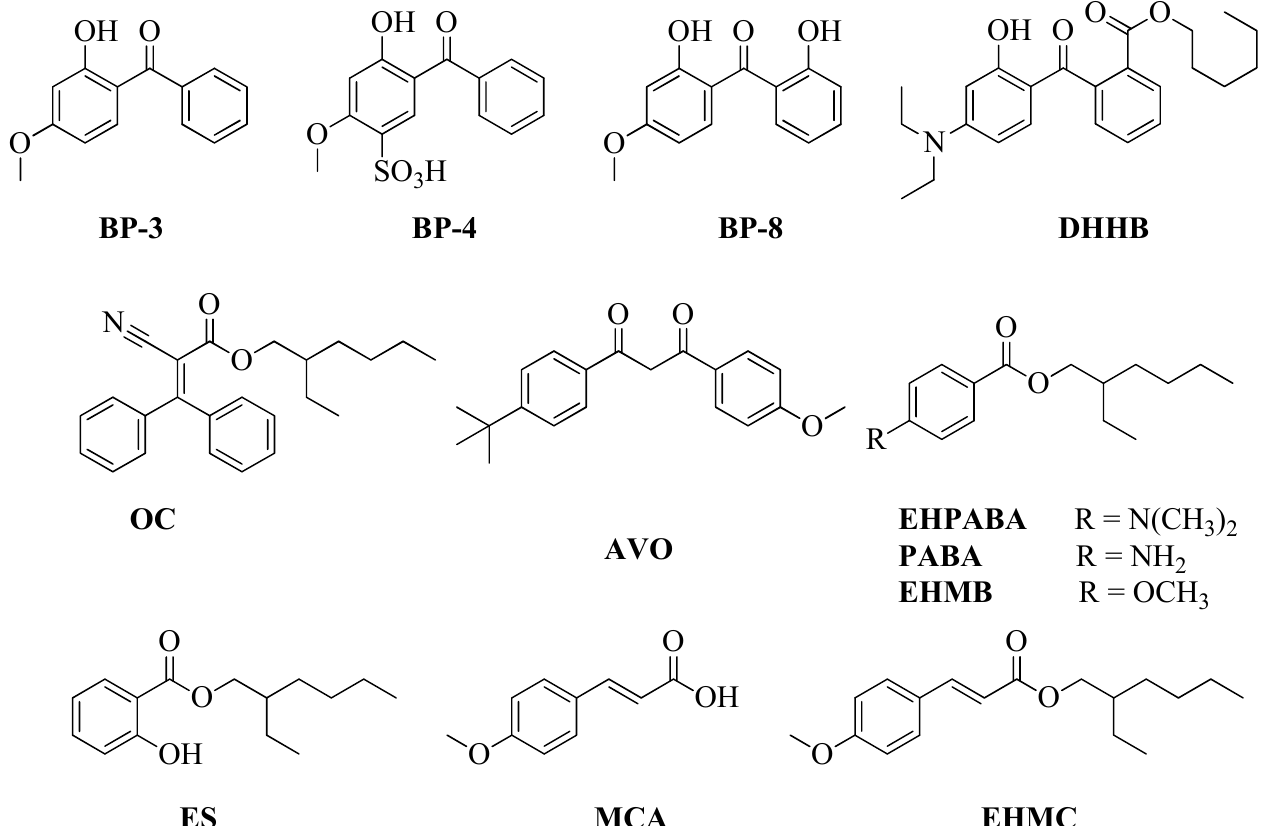
Figure 1. Structures of the most common commercial organic sunscreens.